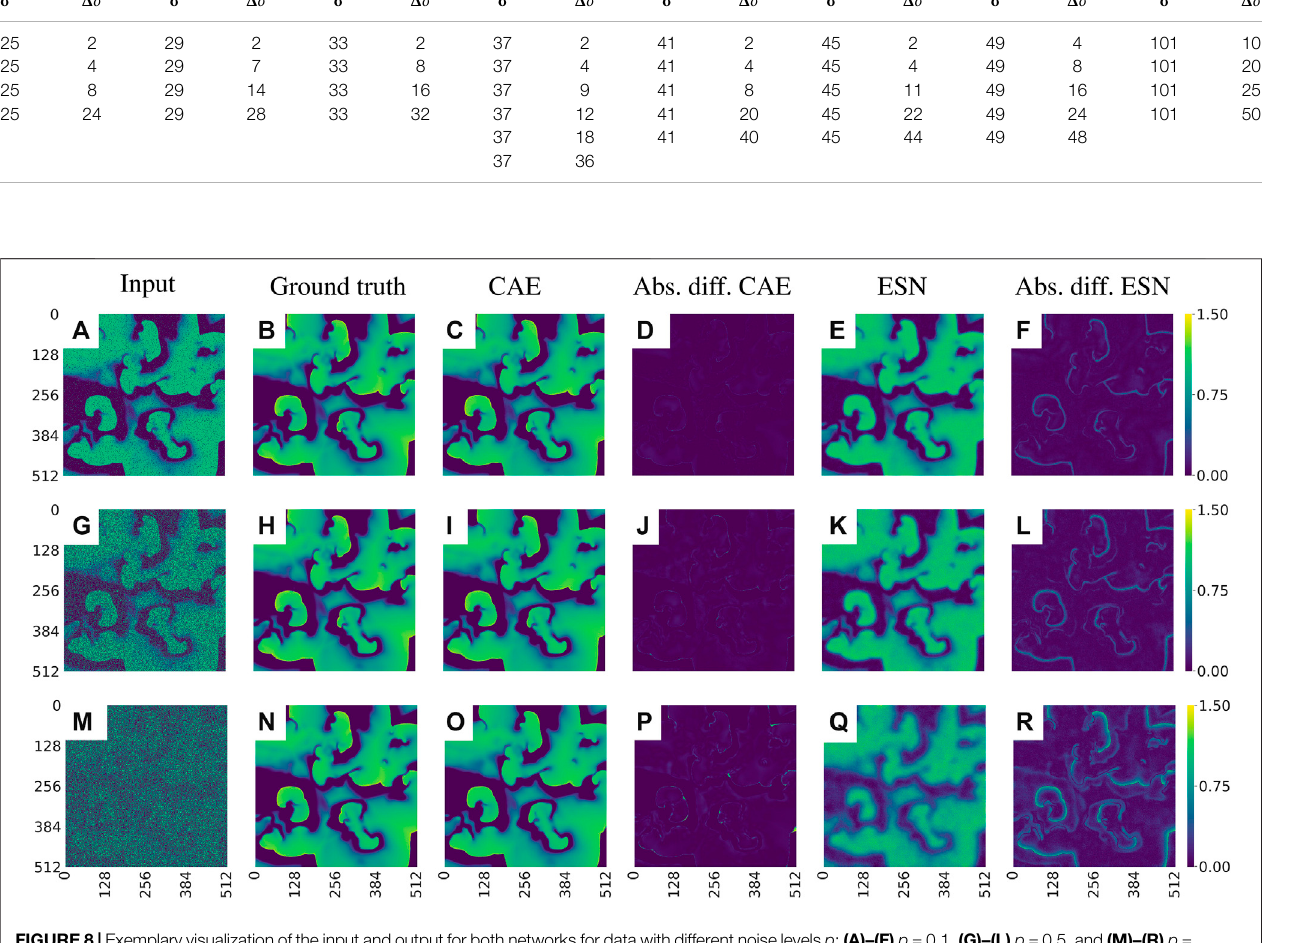
Frontiers in Applied Mathematics and Statistics |